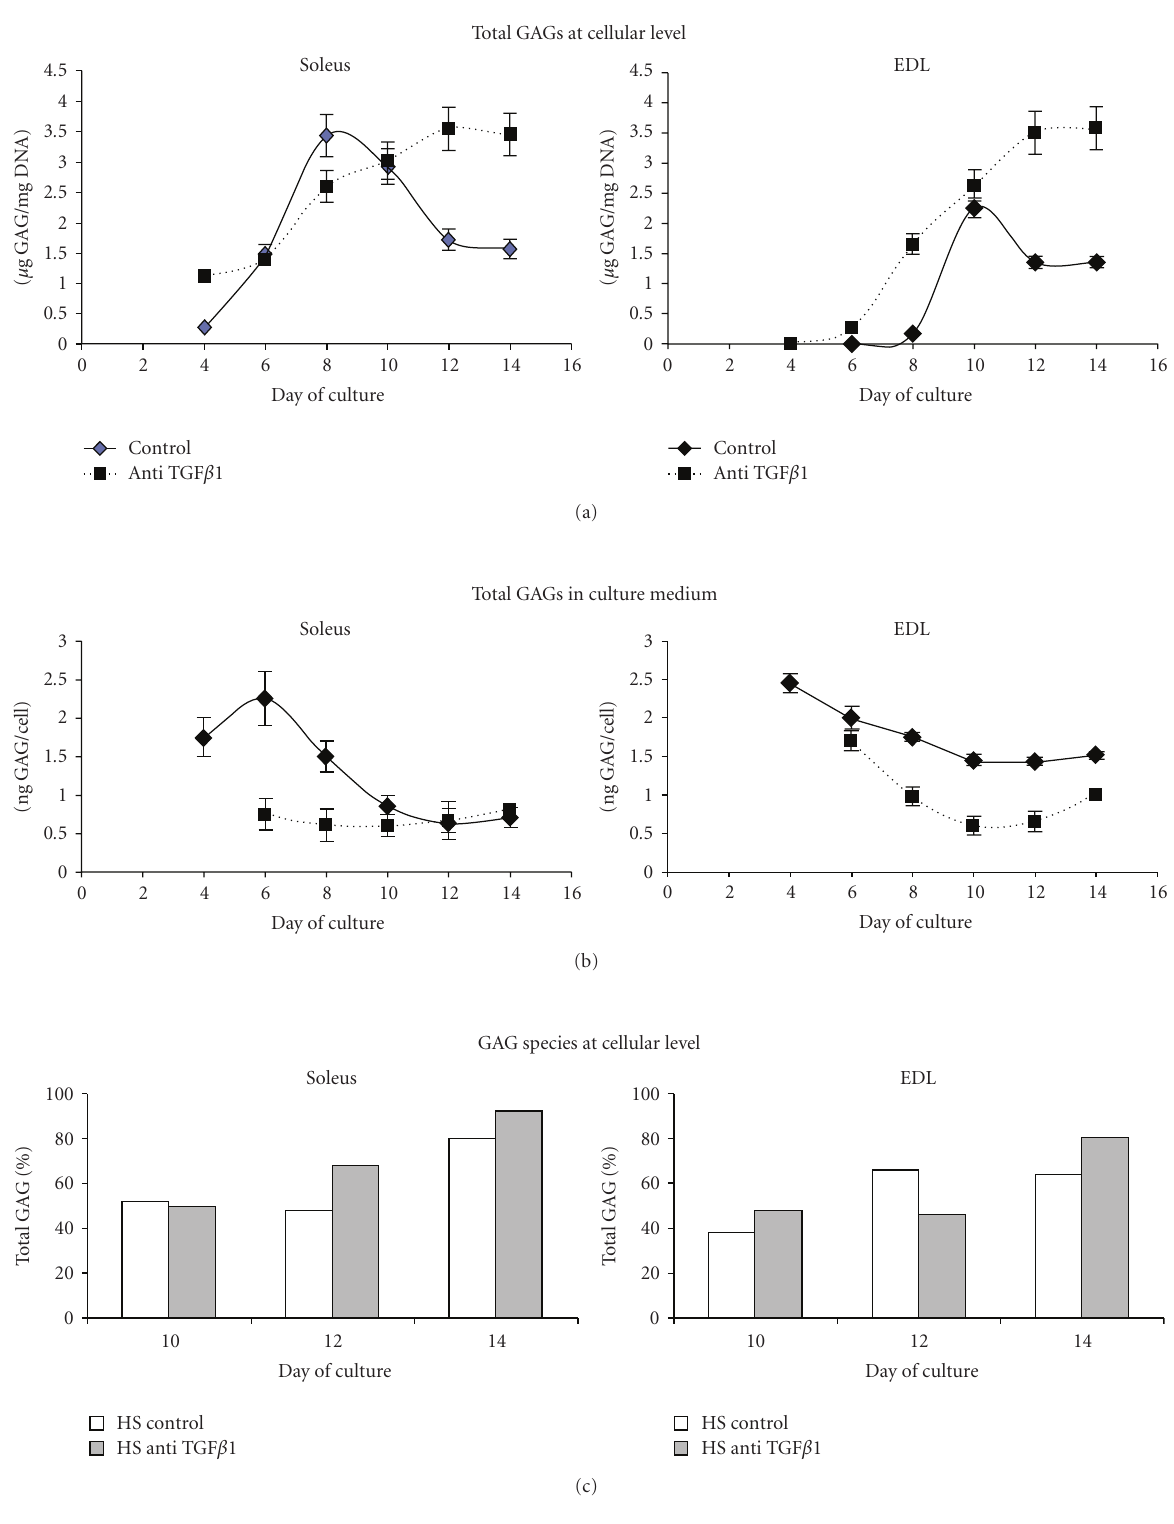
Figure 9: Sulphated GAG levels produced by di ff erentiating myoblasts isolated from soleus and EDL muscles . Untreated myoblasts (control) or myoblast treated at day 4 with anti-TGF β 1 antibody were cultured as described in Materials and Methods. (a) Total sulphated GAGs at cellular level at the indicated days of culture. Data are mean ± SE from 3 determinations. (b) Sulphated GAG levels in conditioned medium of soleus and EDL derived myoblast cultures . Results were expressed as ng of GAG produced per cell ± SE as a result of 3 determinations. (c) Analysis of GAG species in EDL and Soleus derived myoblasts. HS, expressed as % of total GAG, was determined after a chondro¨ıtinase ABC treatment of the total GAG samples. Two determinations, that did not di ff er by more than 10%, were used in this